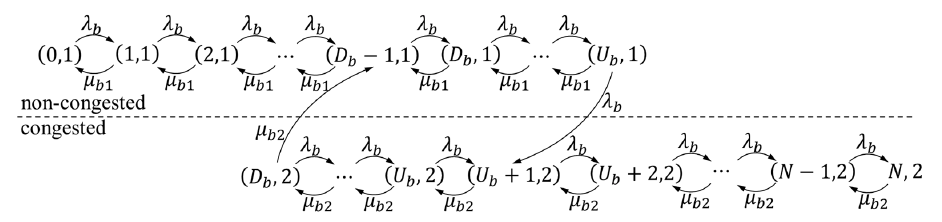
Figure 4. State transition diagram. 231